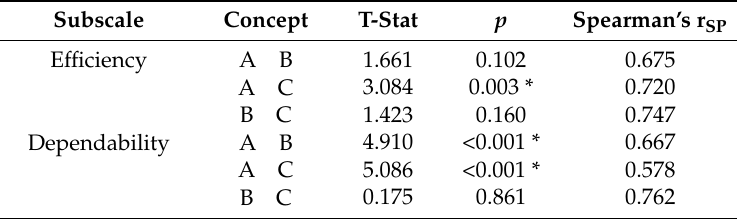
Table 9. Inferential statistic of UEQ with Spearman’s r for subscales’ efficiency and